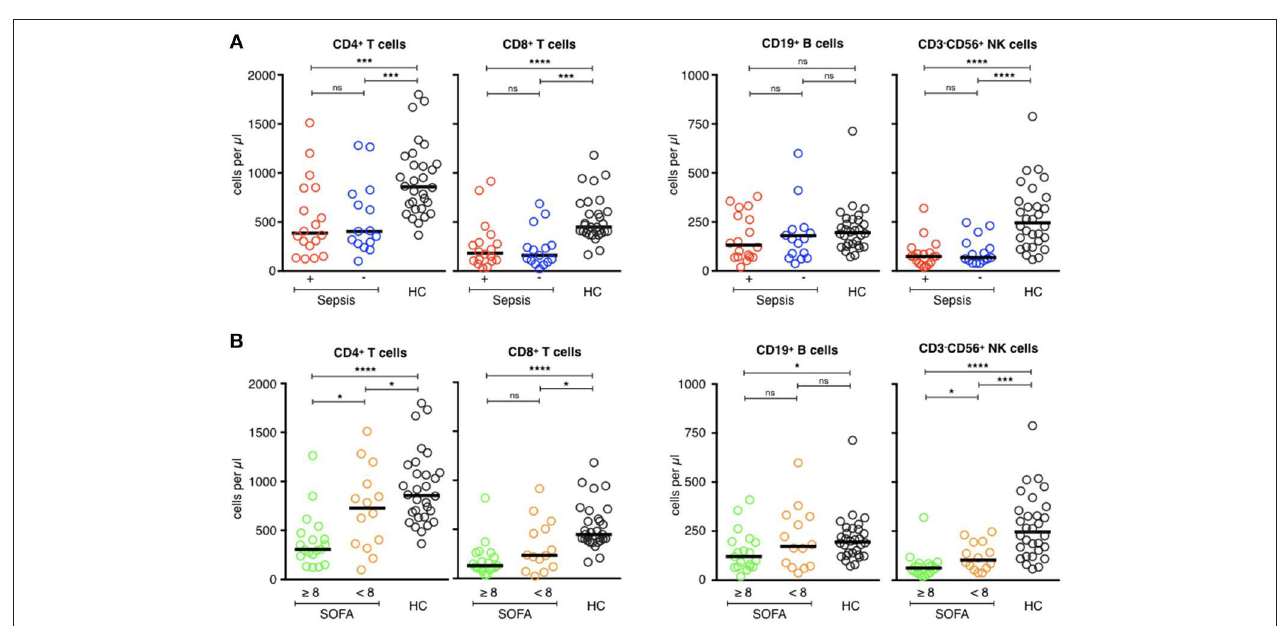
FIGURE 1 | Phenotypic analysis of circulating lymphocyte subsets in ICU patients. (A) Comparison of helper T-cell, cytotoxic T-cell, B-cell, and NK-cell counts (cells/ µ l) of septic patients (red circles) with those of healthy controls (dark circles), and ICU patients without sepsis (blue circles). (B) Comparison of helper T-cell, cytotoxic T-cell, B-cell, and NK cell counts (cells/ µ l) of patients with severe tissue injuries (green circles) with those of healthy controls (dark circles), and patients with less severe lesions (orange circles). The bars show the median. Statistical analyses were performed using the Mann Whitney U -test. Differences were considered significant when P < 0.05: * P < 0.05, *** P < 0.001, **** P < 0.0001. ns: not